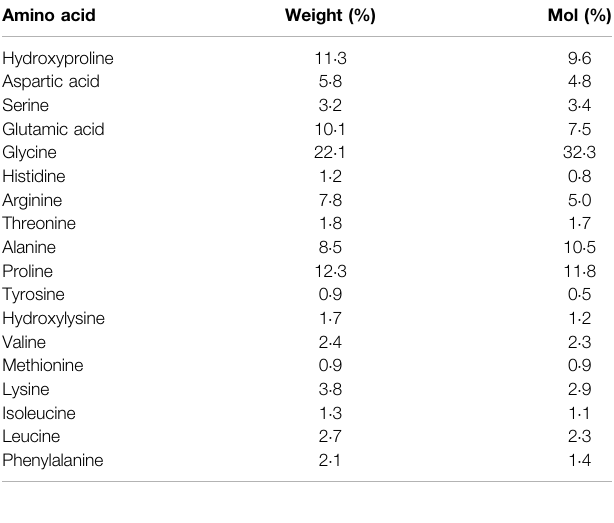
TABLE 1 | Amino Acid Composition of the CP